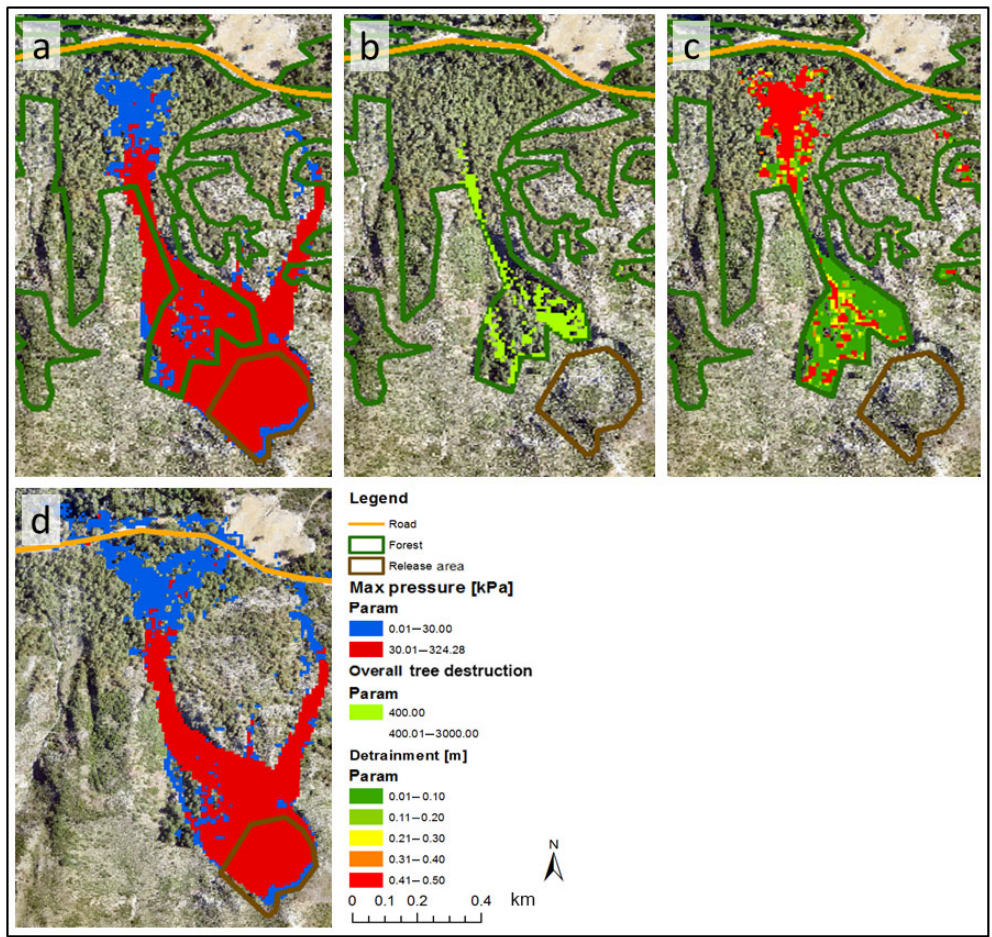
Figure 8. Avalanche simulations at avalanche track 9 with a 100-year return period: (a) maximum pressure of an avalanche scenario with forest, (b) area where forest is destroyed, (c) detrainment in the forest and (d) the maximum pressure of an avalanche scenario without considering